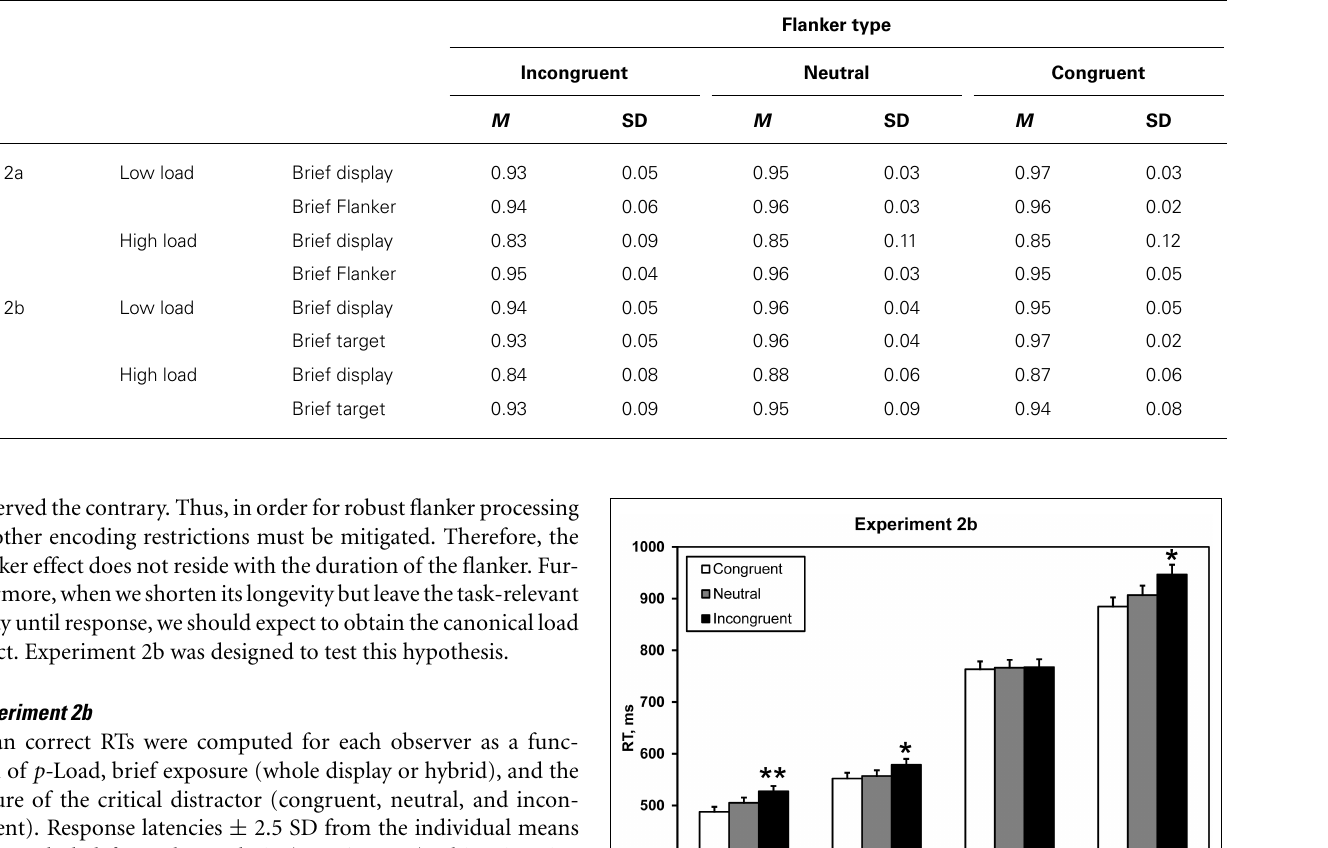
Table 2 | Experiment 2: accuracy performance.